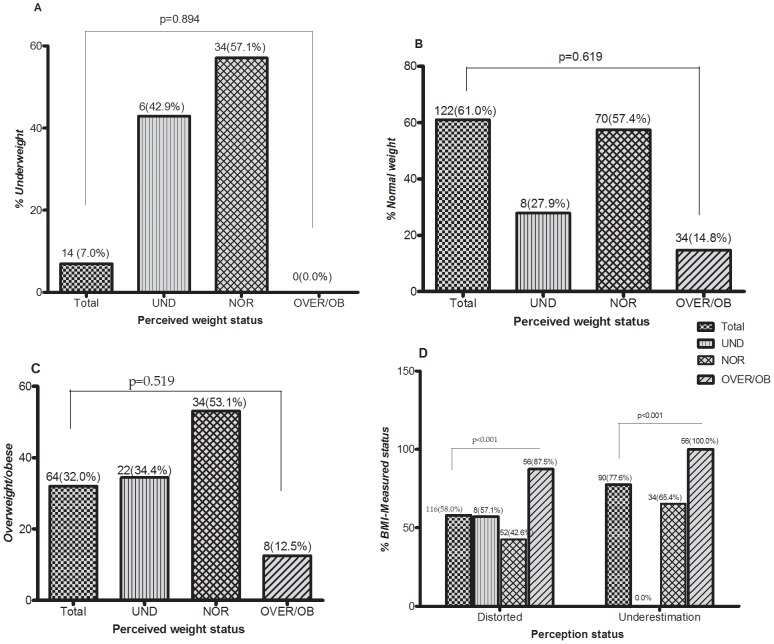

BMI-measured weight status compared to self-perceived weight status.Comparison between BMI-measured weight status with perception of underweight (A); perception of normal weight (B); perception of overweight/obese (C) and perception status (D). UND =  Underweight, NOR = Normal weight, OVER/OB =  Overweight/obesity. Data was presented as proportion and analyzed using chi-square for trend.